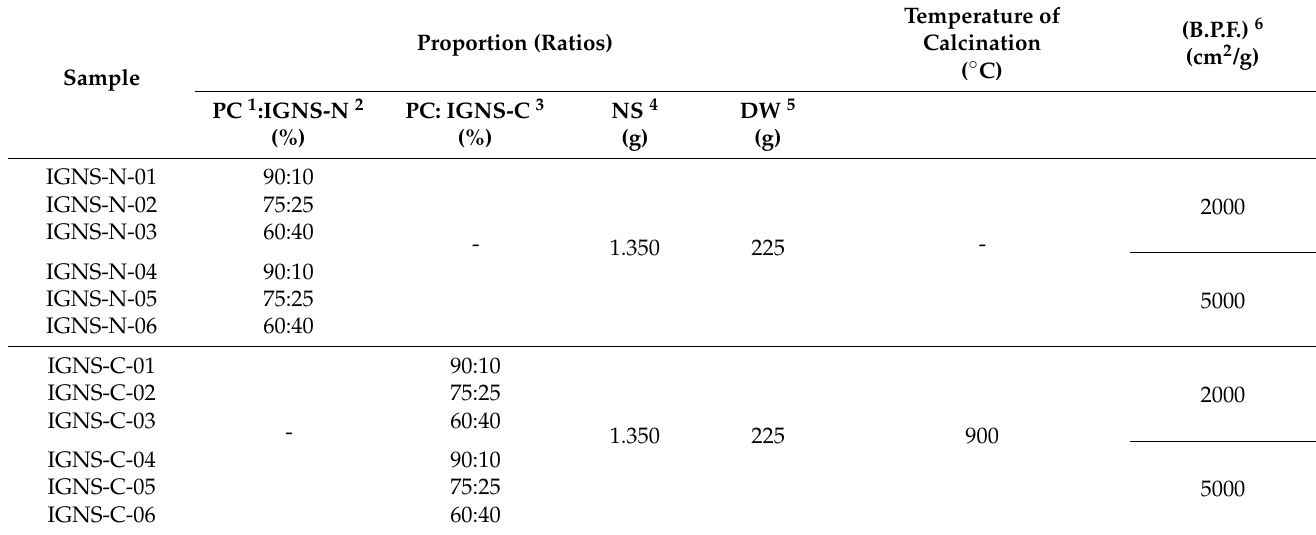
Table 1. Proportions of mixtures of PC/IGNS-N, PC/IGNS-C, NS and DW used in the preparation of mortar specimens.